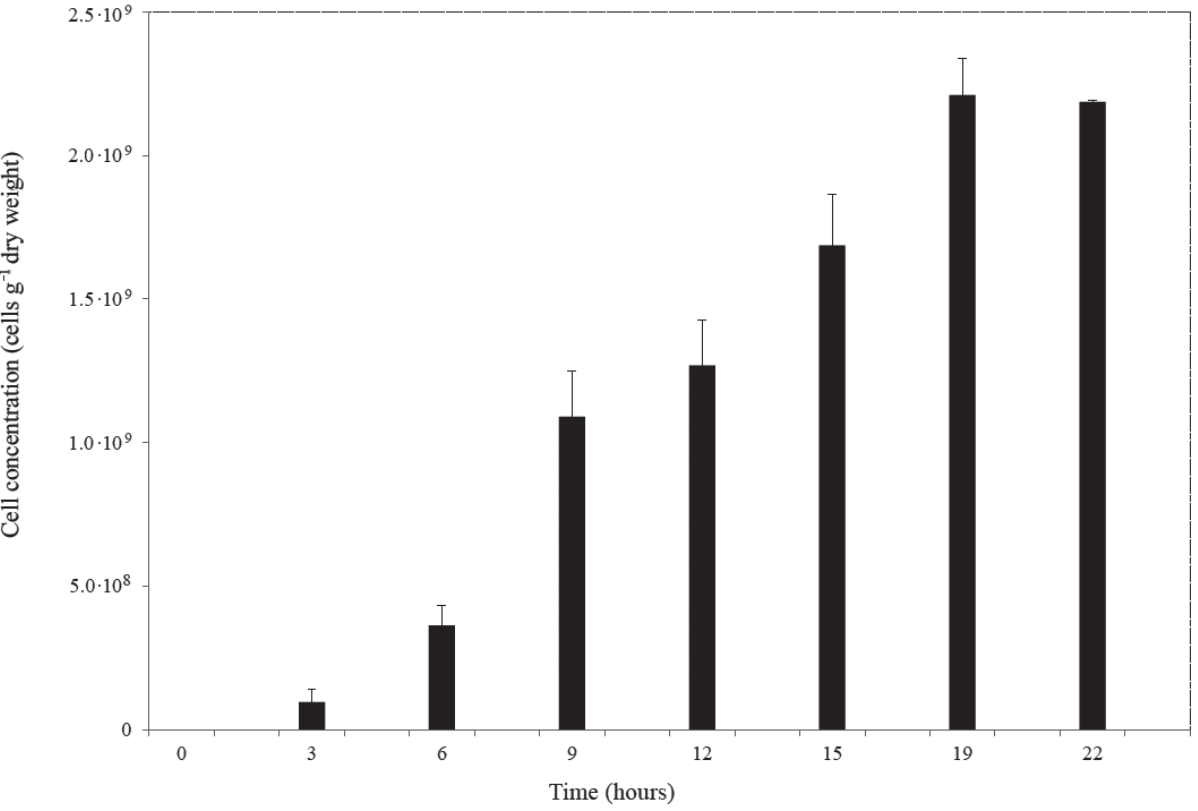
tion of yeast and its application in beer fermenta- tion. The fermentation kinetics obtained with im- mobilized and free suspended cells are shown in Fig. 4. The analysis performed on days 1 and 2 of fermentation revealed that reducing sugar consump- tion and ethanol production rates were higher when immobilized cells were used (16.8±0.92 g d –1 and 8.41±0.58 g d –1 , respectively), compared to fermen- tations carried out with free suspended cells (12.6 g d –1 and 6.28 g d –1 , respectively) (Fig. 4a). Maximum ethanol productivity was attained with immobilized cells (average 6.72 g L –1 d –1 ), showing the efficien- cy of the biocatalyst for alcoholic fermentation.